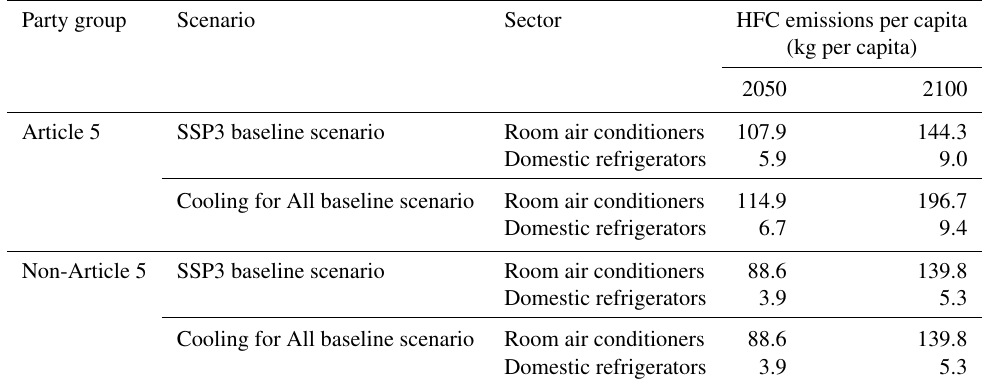
Figure 2. Pre-Kigali SSP3 baseline HFC emissions by regions. Table 3. Pre-Kigali baseline HFC emissions per capita in residential air conditioning and domestic refrigerators under the SSP3 and Cooling for All